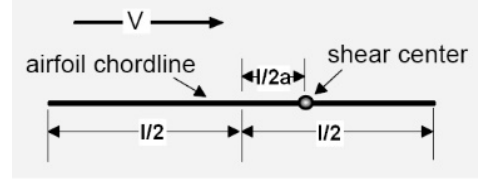
Figure 7. control point location on the airfoil section